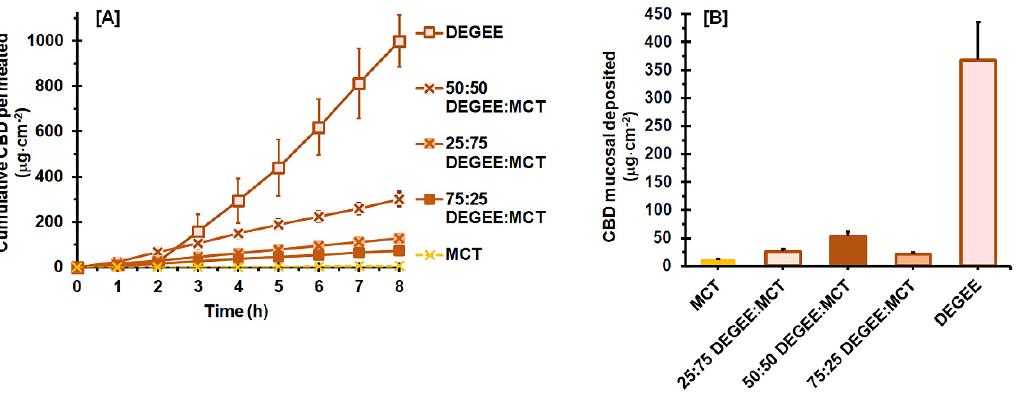
Figure 3. Ex vivo permeation profiles ( A ) and mucosal deposition amount ( B ) of CBD with the DEGEE:MCT binary vehicle systems, when compared with neat MCT and DEGEE (mean ± SD, n = 4).